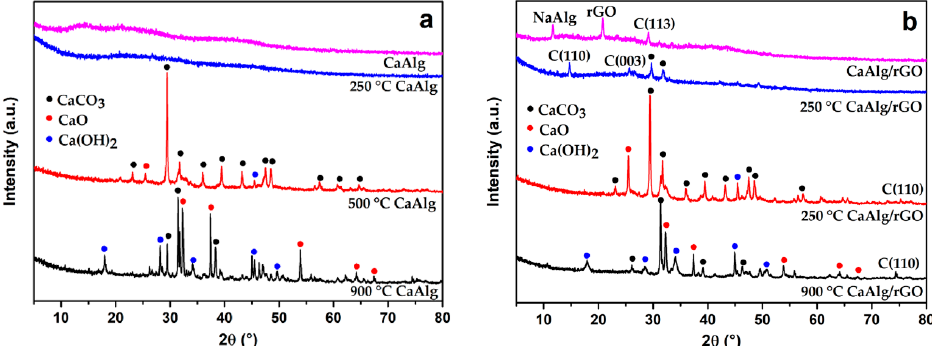
Figure 2. X-ray diffraction (XRD) patterns of the ( a ) CaAlg and ( b ) CaAlg/rGO